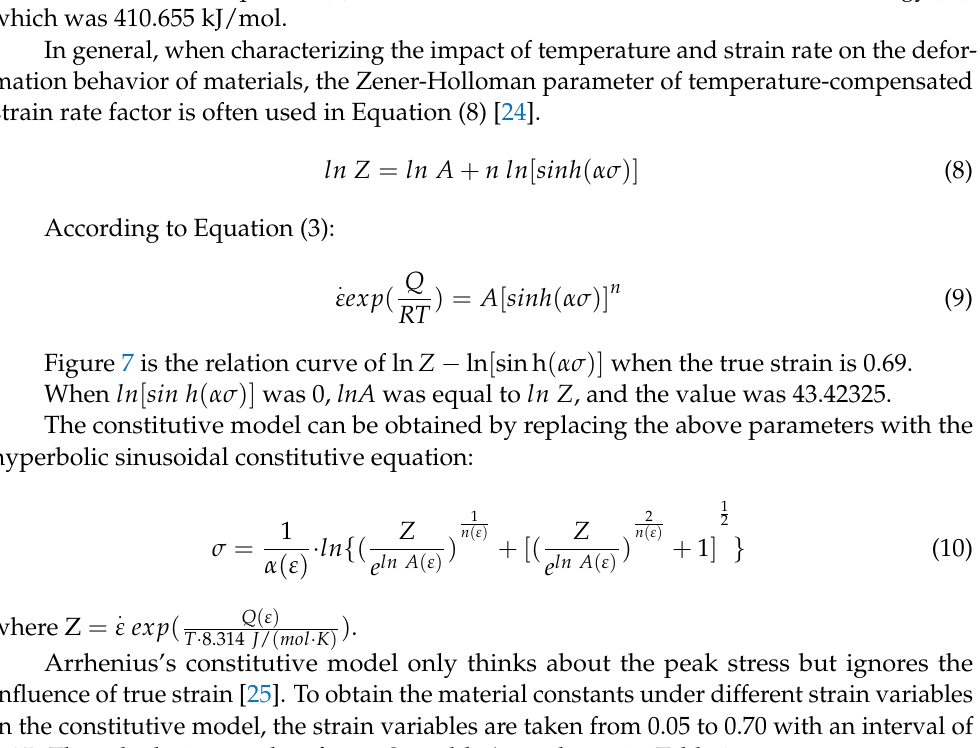
Figure 6. Relationship between ( a ): 𝑙𝑛 𝜀(cid:4662) − 𝑙𝑛[𝑠𝑖𝑛 ℎ(𝛼𝜎)] , ( b ): 𝑙𝑛[𝑠𝑖𝑛 ℎ(𝛼𝜎)] − 1000/T(K − 1 ).